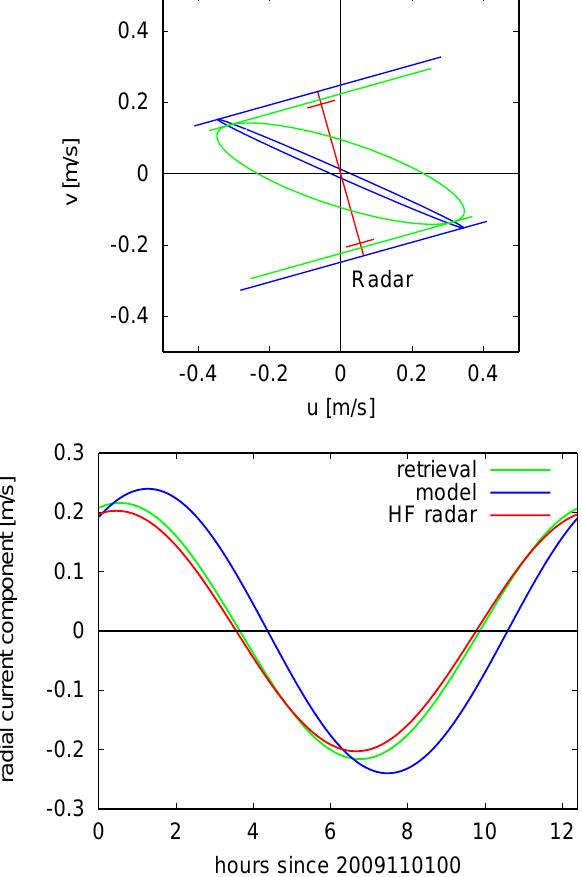
Fig. 10. Illustration of the tidal ellipses parameter retrieval method. F IG . 10. Illustration of the tidal ellipses parameter retrieval method. (left) The blue ellipses (top) The blue ellipses is derived from the numerical model for is derived from the numerical model for the position 7.75 ◦ E54.26 ◦ N (west of Helgoland) on the position 7.75 ◦ E 54.26 ◦ N (west of Helgoland) on 1 Novem- Nov 1, 2009. The red lines indicate the amplitude of the radial component measured by the ber 2009. The red lines indicate the amplitude of the radial com- radar at Wangerooge. The green ellipses is obtained by combination of the HF radar data ponent measured by the radar at Wangerooge. The green ellipses is and model information using models for both forecast and measurement errors. (right) obtained by combination of the HF radar data and model informa- Time series of the radial M 2 current components with the same color coding as in the left tion using models for both forecast and measurement errors. (bot- plot. tom) Time series of the radial M2 current components with the same color coding as in the upper plot.